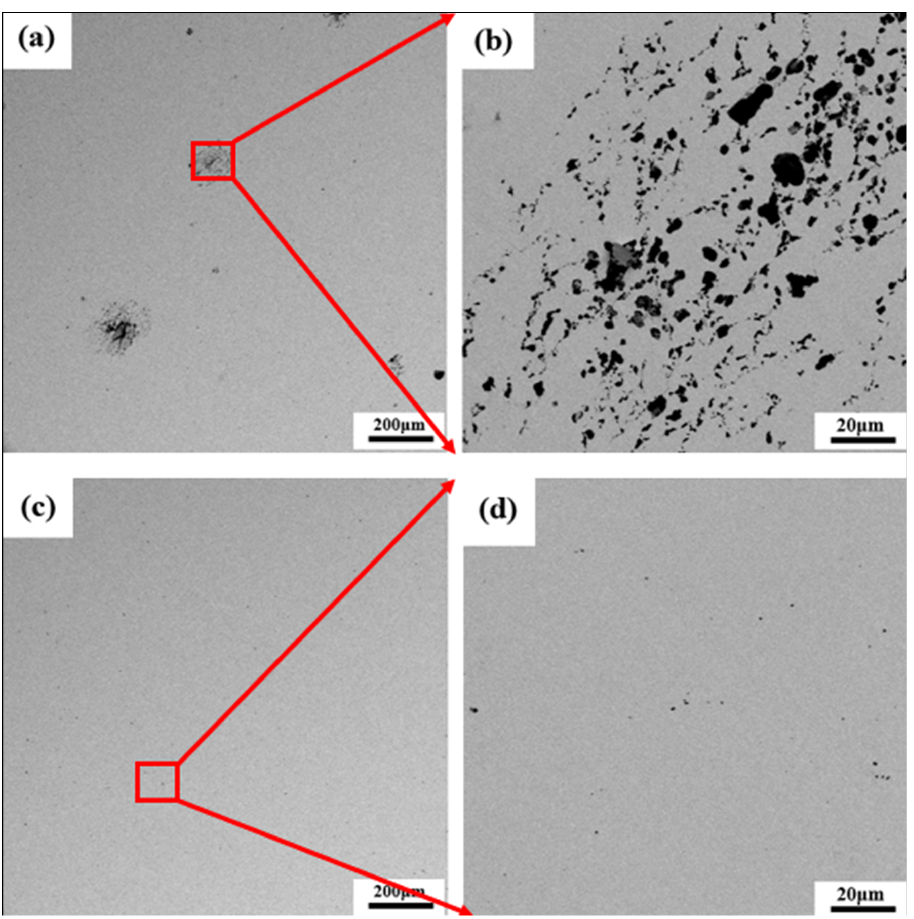
Figure 5. Surface morphologies of corroded HNS ( a ) corrosion morphology, ( b ) high magnification of the red square in Figure 5a, and ST ( c ) corrosion morphology, ( d ) magnification of the red square in Figure